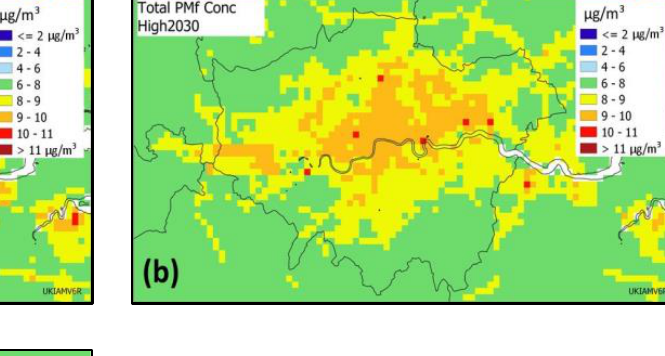
Figure 8. In 2040, ( a ) the baseline and ( b ) the medium scenario show large areas of London remain at risk of exceedance, whereas ( c ) the high ambition and ( d ) the speculative scenario almost remove all areas (orange) at risk of exceeding exceeding 10 µg m − 3 .